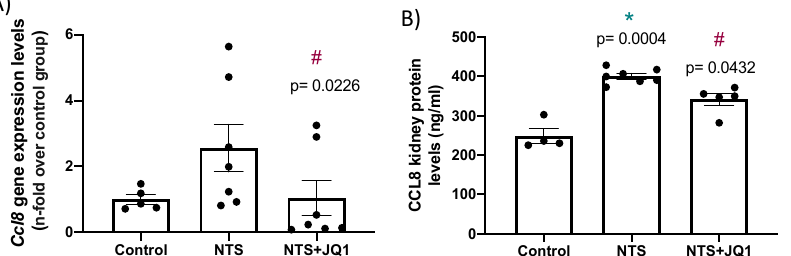
Figure 6. JQ1 diminishes kidney CCL8 levels in the nephrotoxic nephritis. NTS mice were treated daily with JQ1 (100 mg/kg body weight per day) or vehicle. RNA and proteins were isolated from frozen samples of whole kidney. ( A ) Ccl8 gene expression levels were evaluated by real-time qPCR, and ( B ) CCL8 protein levels were determined by ELISA. Data are expressed as the mean±SEM of 5– 7 animals per group. * p < 0.05 vs. control; # p < 0.05 vs. NTS.